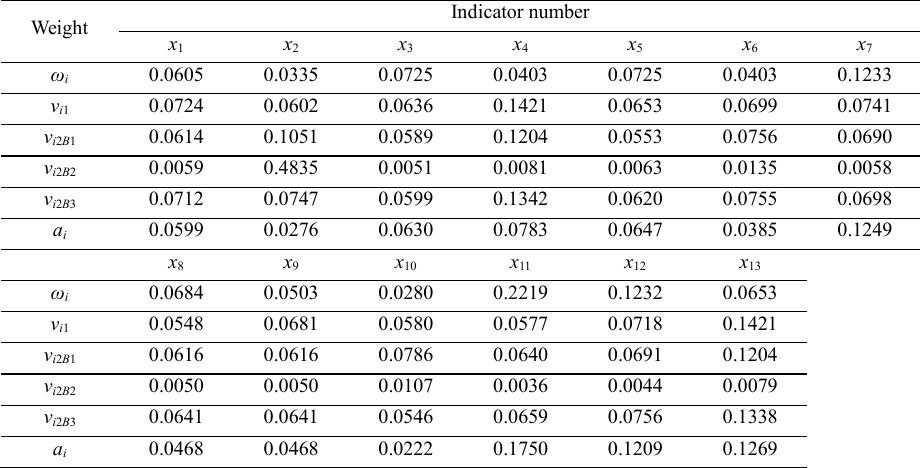
Table 3. The comprehensive weight of